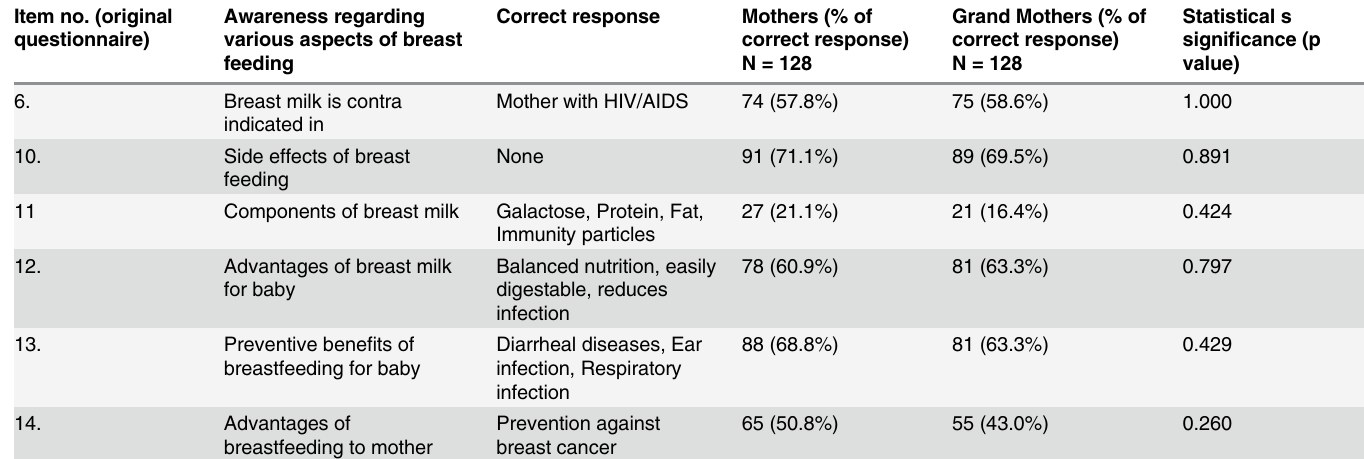
Table 3. Comparison of awareness regarding contraindications, advantages and disadvantages of breast feeding to the child and the mother. Item no. (original questionnaire)